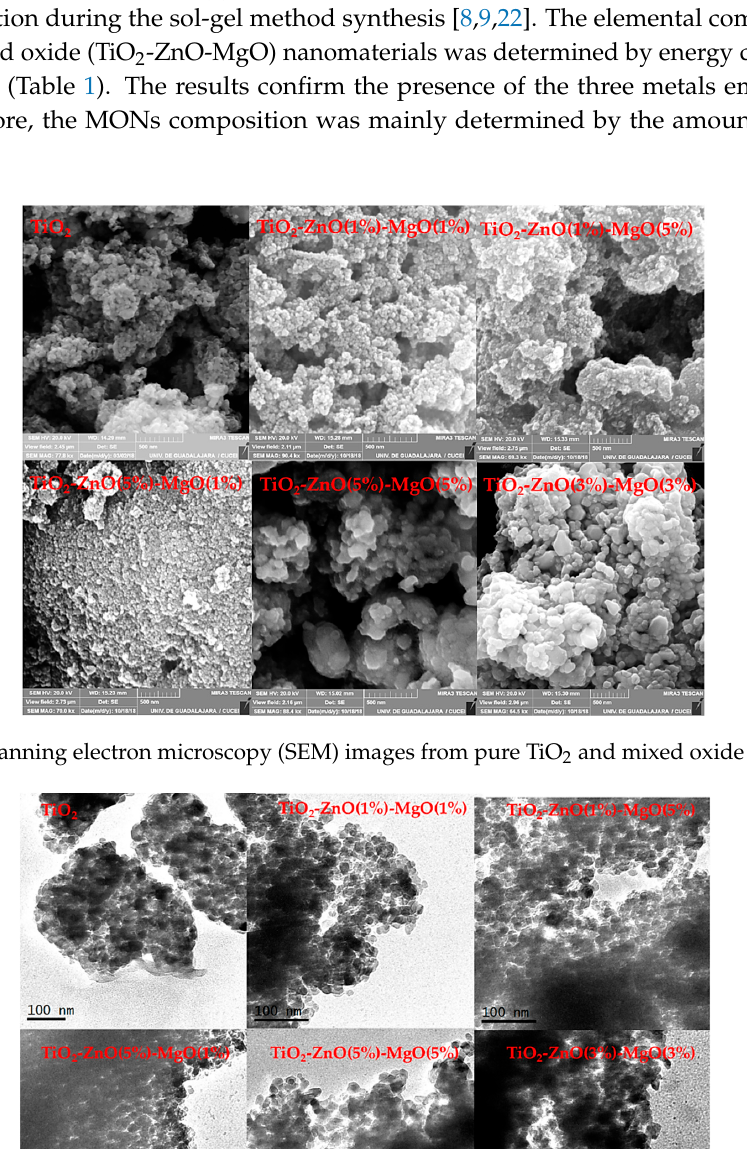
2 and mixed oxide